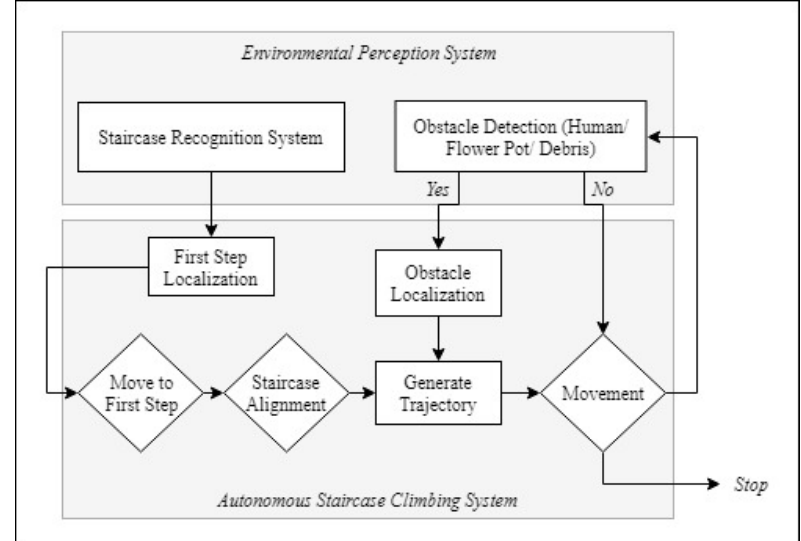
Figure 5. Proposed Scheme.